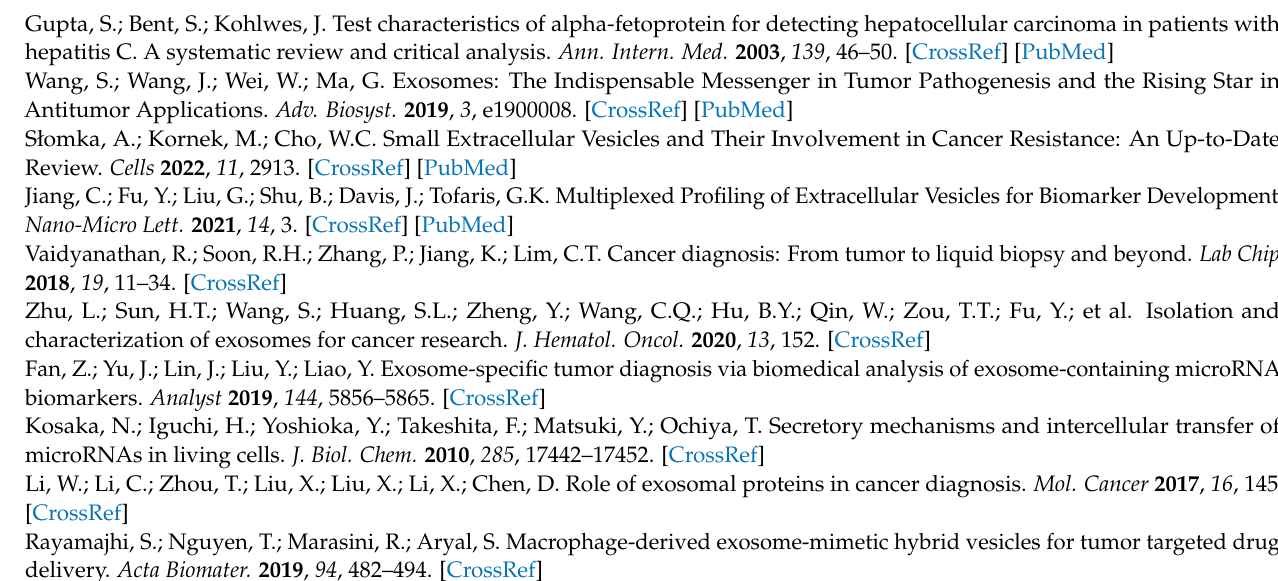
antibodies for Western blot. Table S5: The diagnostic performance characteristics from three miRNAs in the training set and validation set. Table S6: The correlation between three exosome-derived miRNAs and clinicopathological characteristics of HCC. Supplementary Materials S2: Differentially expressed serum-exosome-derived miRNAs in HCC vs. non-tumor donors. miR-122-5p, let-7d-5p, and miR-425-5p are the three serum-exosome-derived miRNAs with the most significant differences. Blue is used to mark the miRNAs with a false discovery rate (FDR) < 0.05, and red is used to mark the miRNAs from 5’ of the precursor miRNAs. Supplementary Materials S3: Novel serum-exosome- derived miRNAs in HCC vs. non-tumor donors (sheet 1). The sequences of novel identified